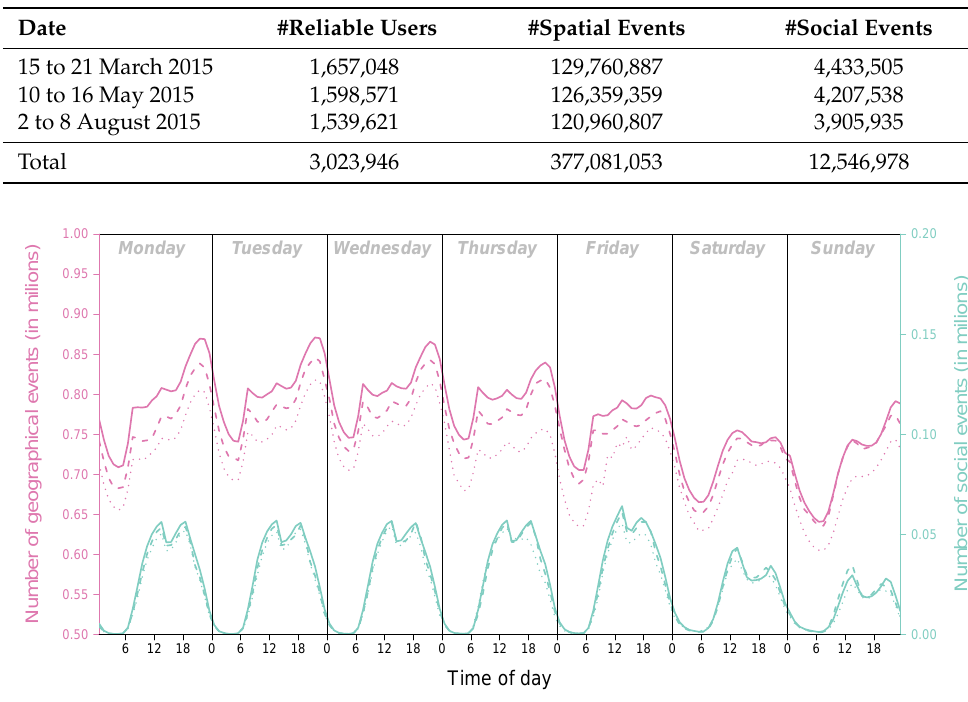
Table A2. Number of reliable users, spatial and social events per week and in total.